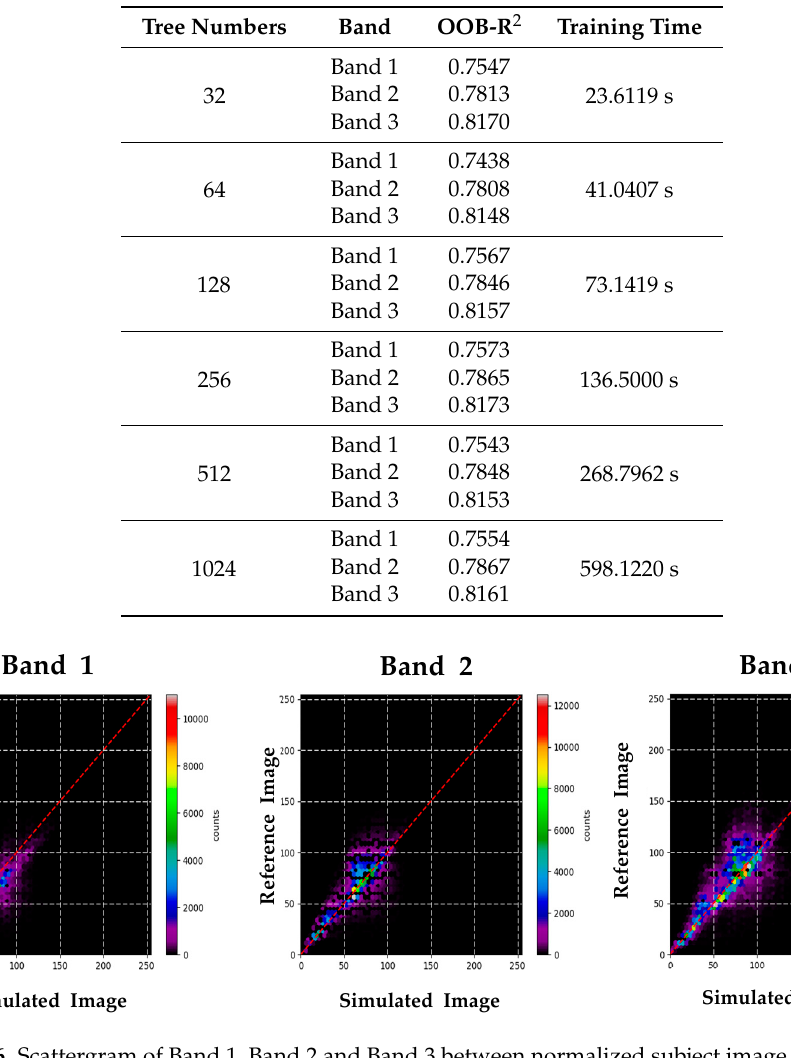
Table 3. OOB-R 2 and training time of RF regression.